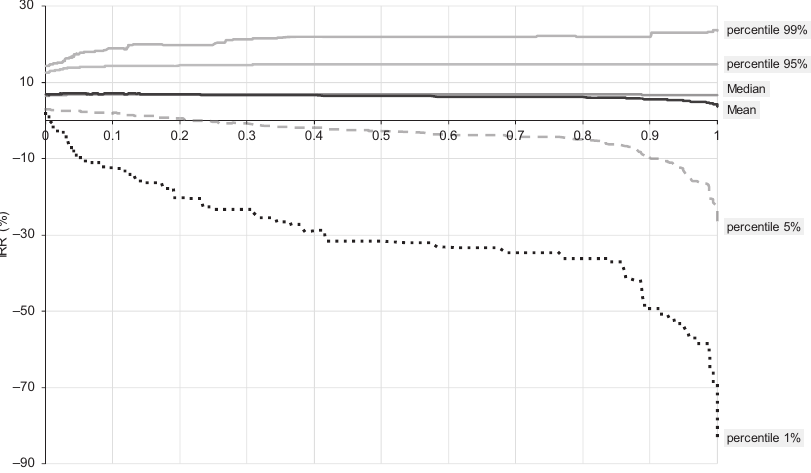
Figure 3. Descriptive